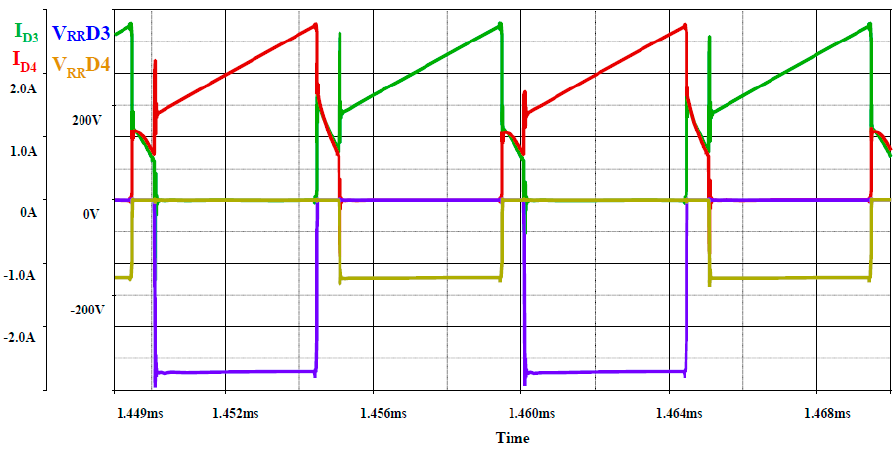
Figure 16. Voltage and current waveforms of the power transistors T 1 , T 2 (100% of output power)—measurement.